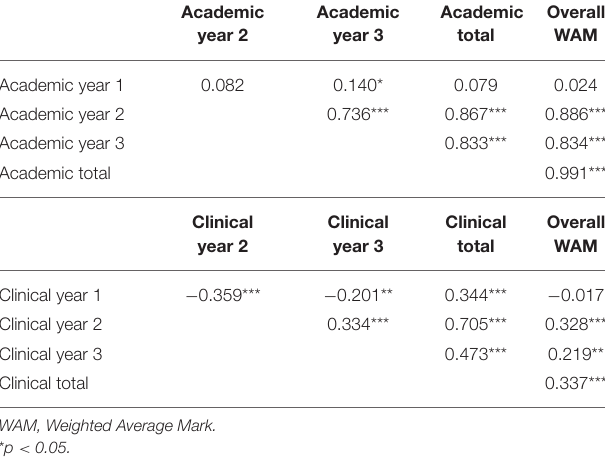
TABLE 2 | Correlation matrix for yearly and overall WAM of academic and clinical performance.